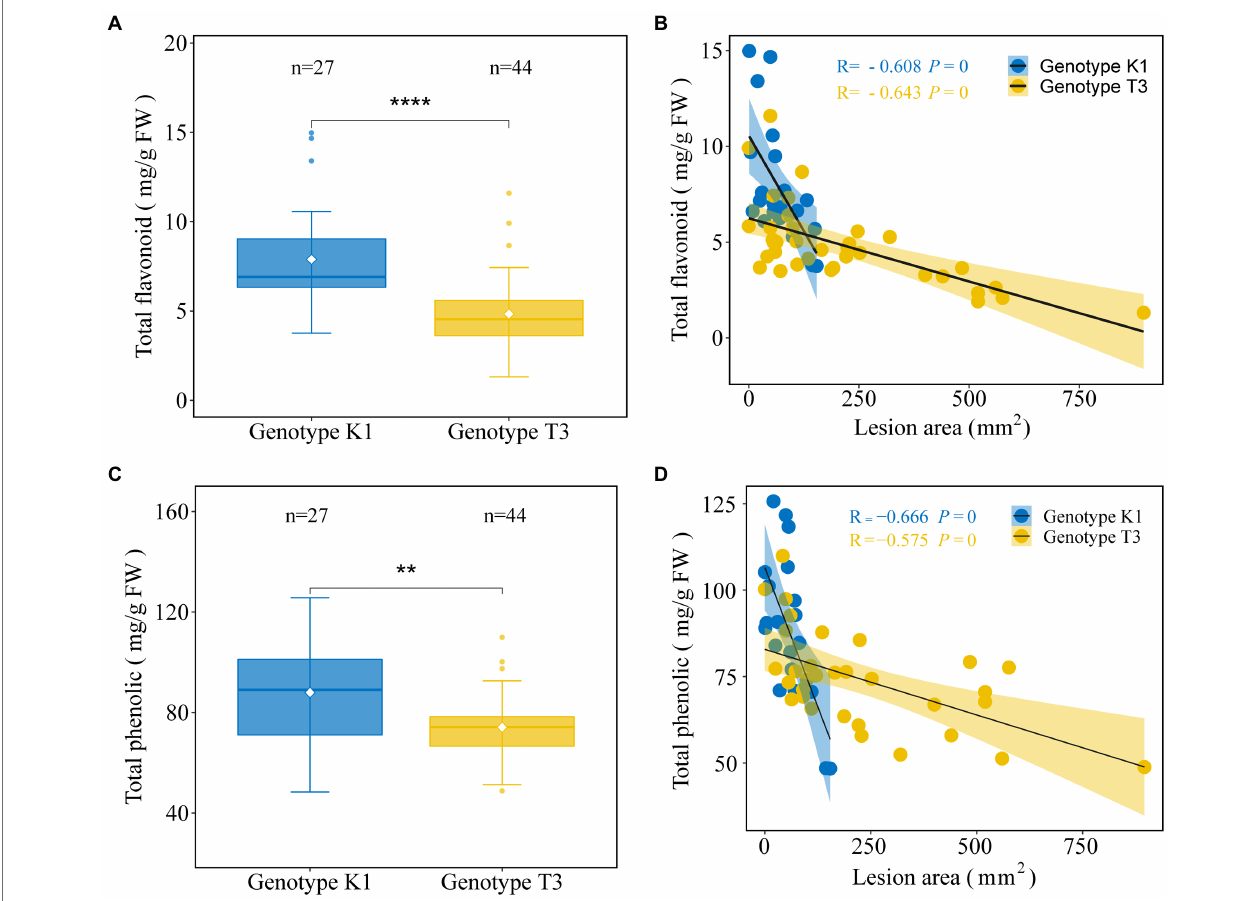
FIGURE 10 | Analysis of total flavonoid and total phenolic contents of leaves of Kreuzkogel 1 (K1) and Tenno 3 (T3). The amount of total flavonoid (A) and total phenolic (C) in strawberry middle and right leaflets for K1 and T3 without B. cinerea inoculation. Significant differences between two genotypes, based on a t -test, are represented by ** p < 0.01 and **** p < 0.0001. The individual points represent the outliers. The correlation between lesion area, measured on strawberry left leaflets, at 5 days after B. cinerea inoculation and total flavonoid (B) and total phenolic contents (D) in strawberry middle and right leaflets without B. cinerea inoculation for K1 and T3,